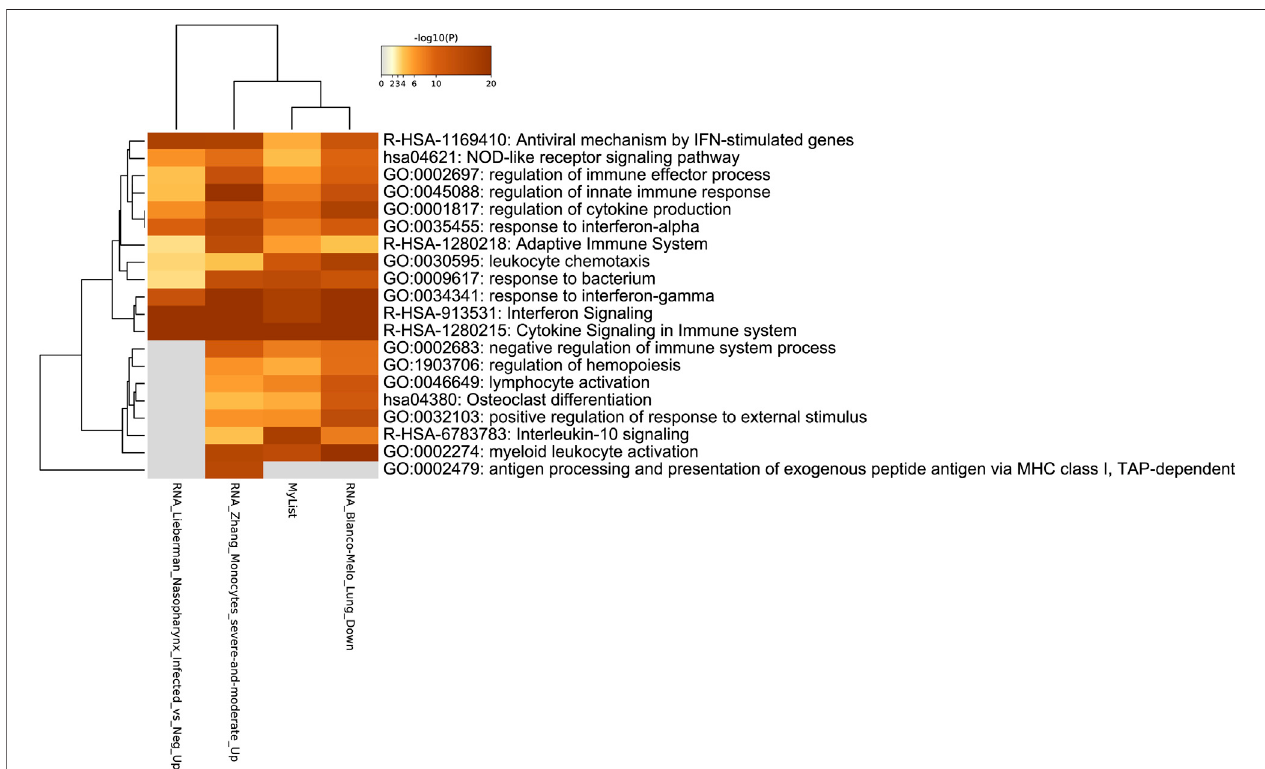
FIGURE 8 | Heatmap of enriched genes for COVID-19 related pathways in upper airway